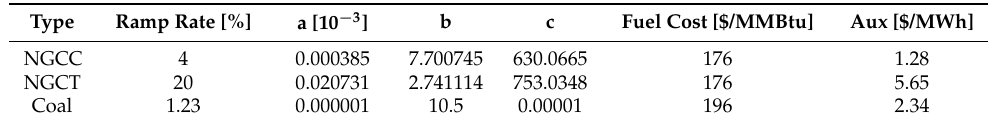
Table 1. Ramp rates, cost coefficients, and fixed maintenance and operation costs for the three types of thermal generation considered in the case